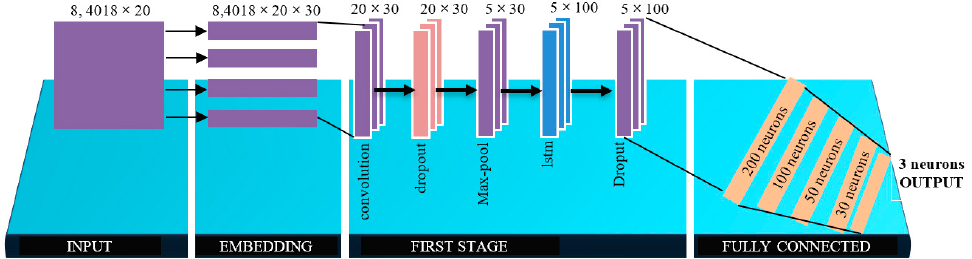
Figure 2. CNN-LSTM architecture for sentiment analysis.